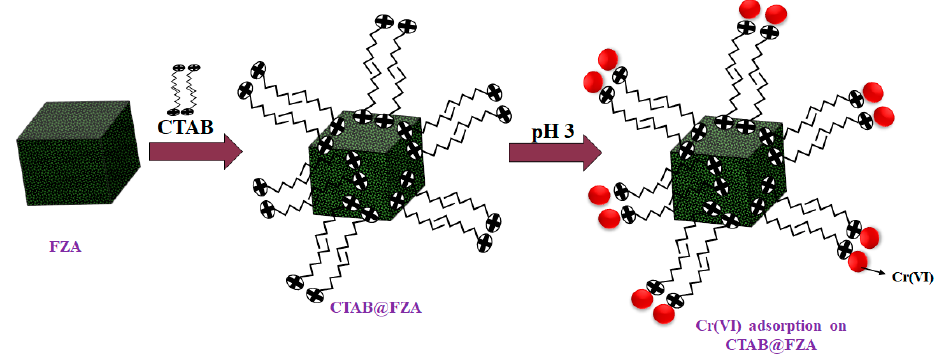
Figure 1. Schematic diagram of CTAB@FZA for Cr(VI) removal.